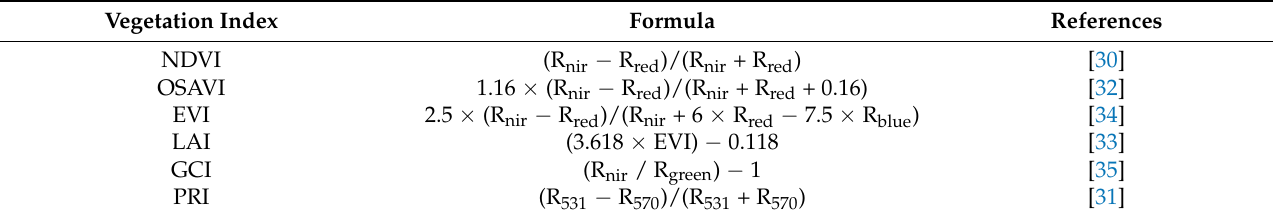
Table 4. Vegetation indexes (VIs) used in this